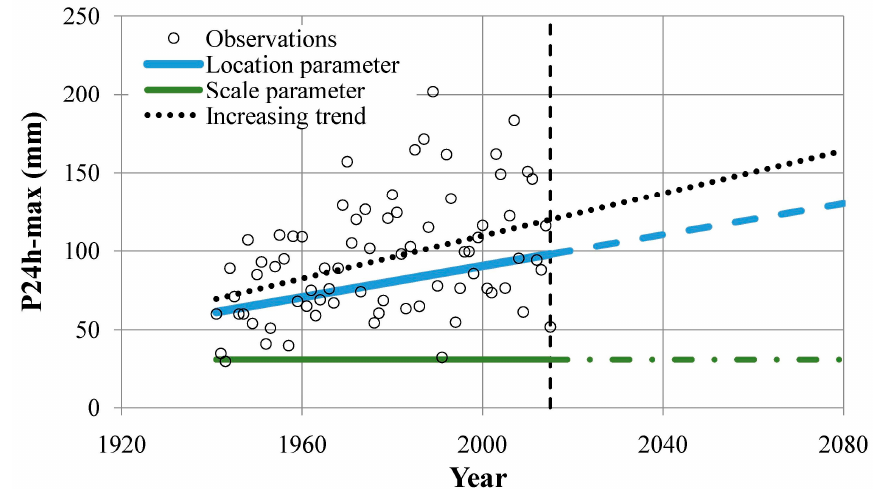
Figure 5. P 24h-max and GEV parameters (location and scale) behavior over time (Rafael Núñez airport station). Table 5. P 24h-max values for non-stationary freq.